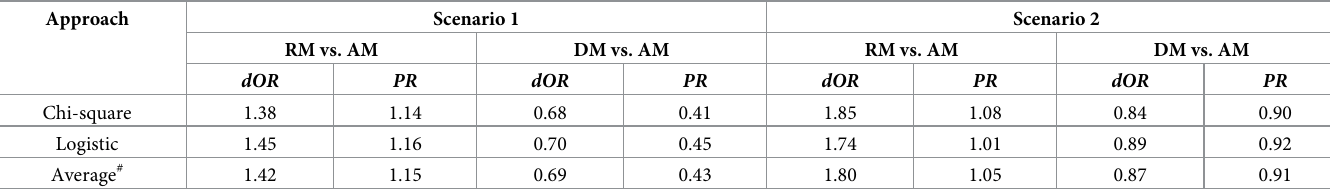
Table 1. dOR s and PR s on simulation